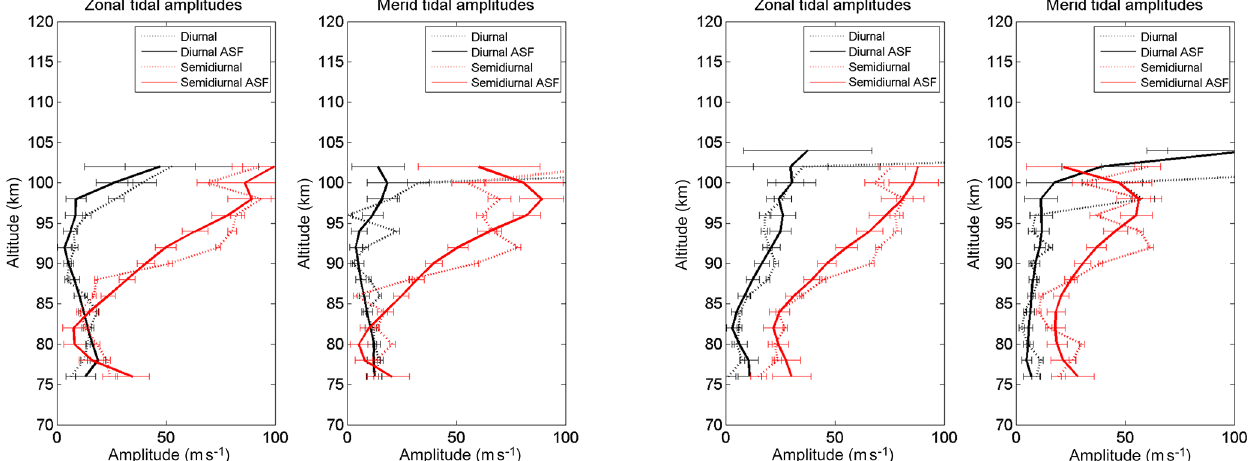
Figure A1. Here, we show observations from 1 February 2010 and the Juliusruh meteor radar. The dashed lines indicate the tidal solution by applying only temporal fitting and the solid lines show the ASF solution with vertical regularization for the diurnal and semidiurnal